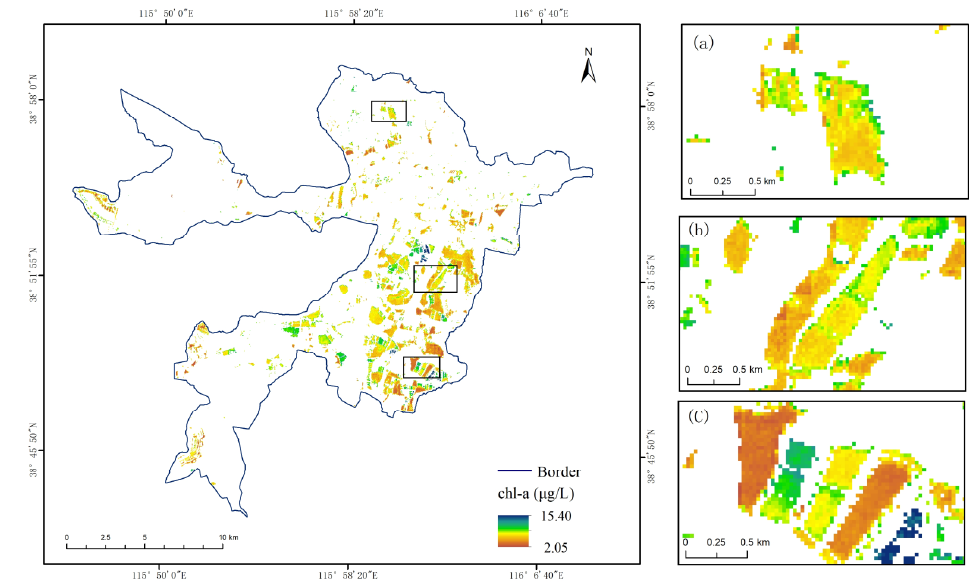
Figure 10. Results of the chlorophyll-a inversion for Baiyangdian Lake. ( a ) Shaochedian Lake; ( b ) Laowangdian Lake; ( c ) Jinlongdian Lake.